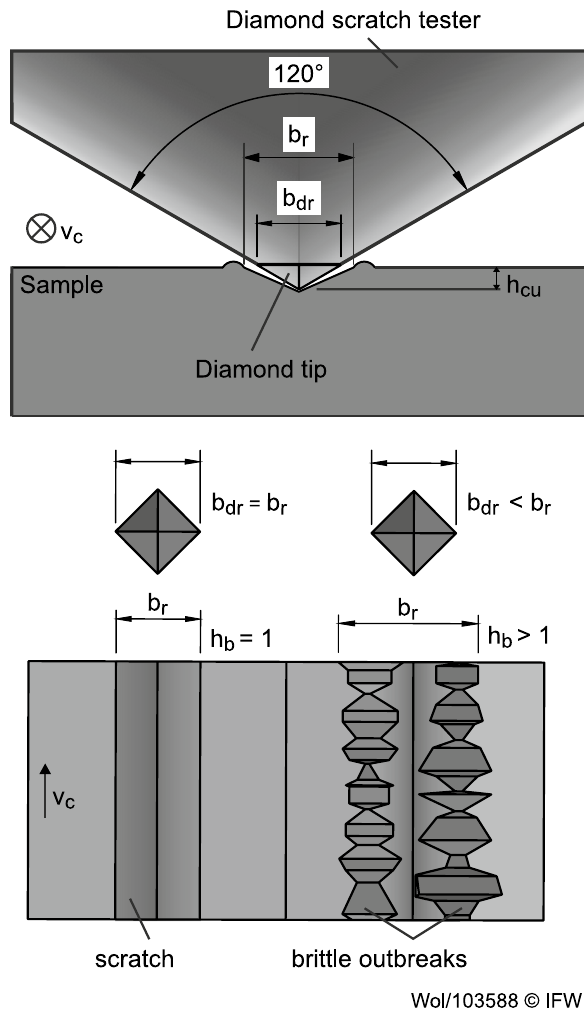
Fig. 5 Width removal factor h